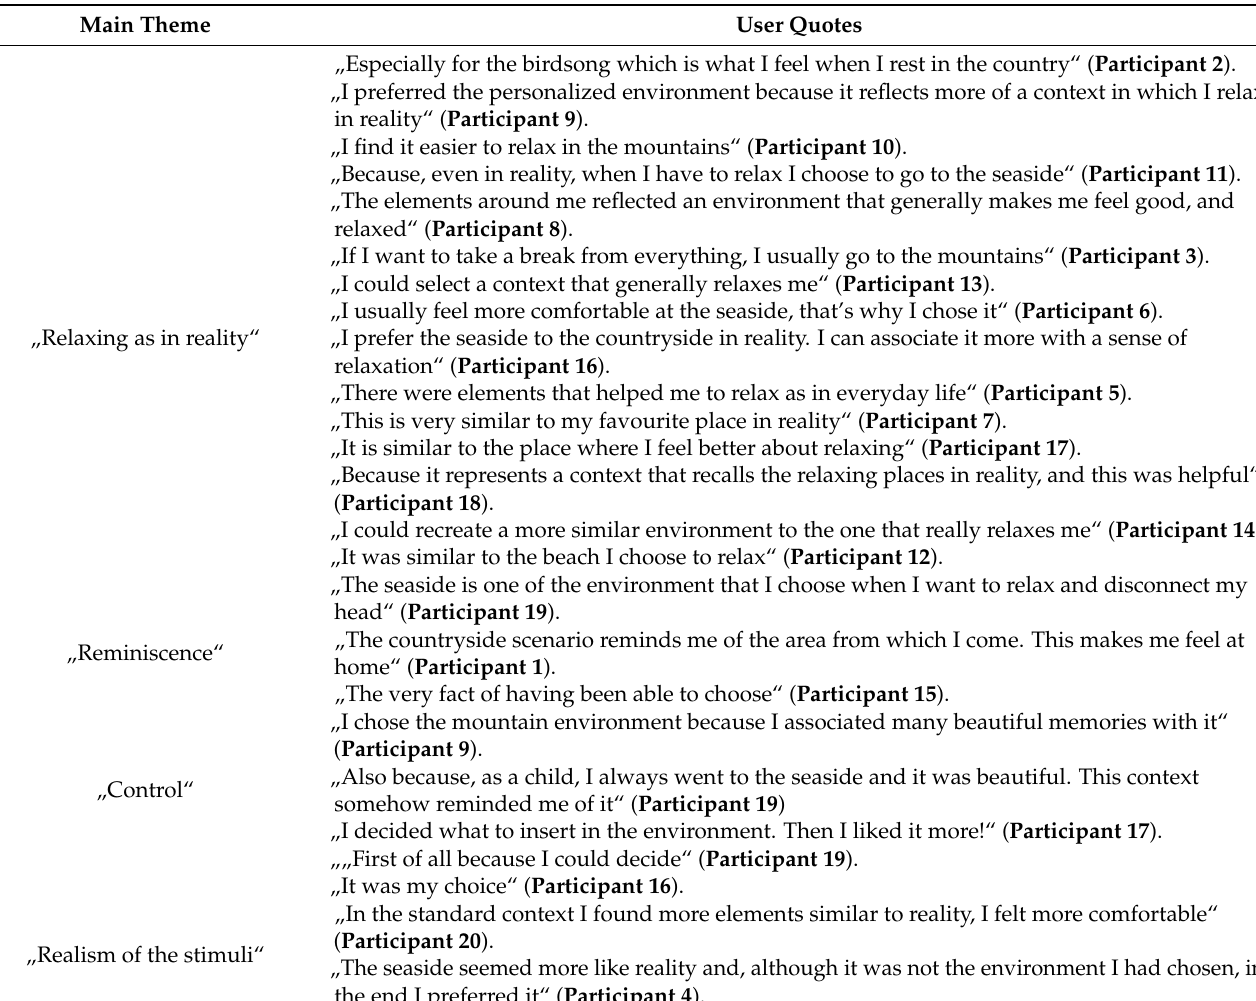
Table 4. Themes and quotes by